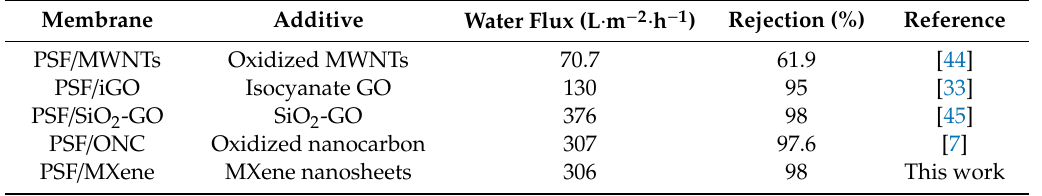
Figure 11. Fouling resistance ratios of the MXene / PSF membranes. Table 4. Comparison of different antifouling polysulfone based membranes.